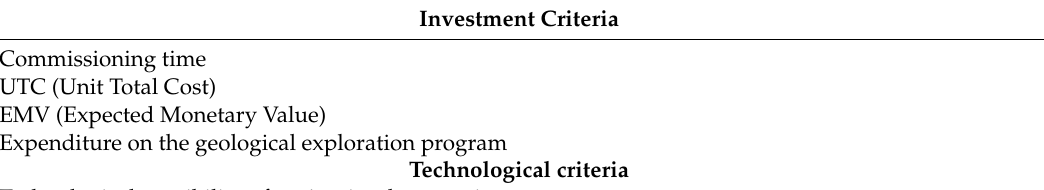
Table 2. Grouping of assessment criteria for o ff shore oil and gas